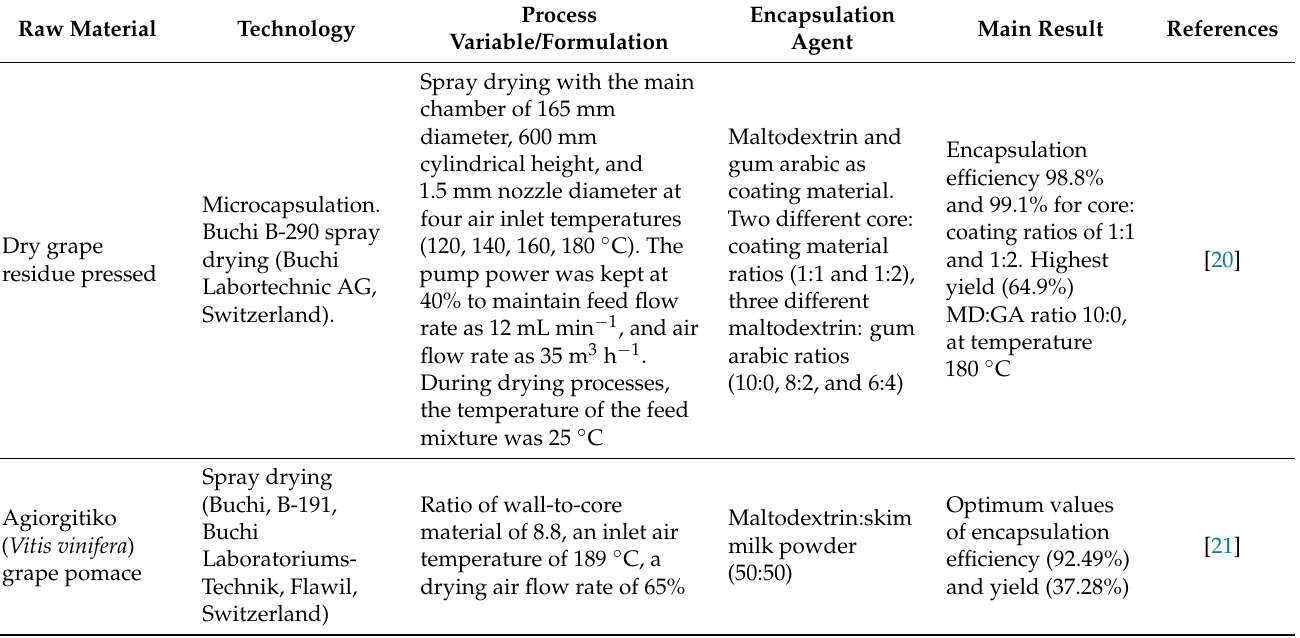
Table 2. Main technologies for the encapsulation of winemaking